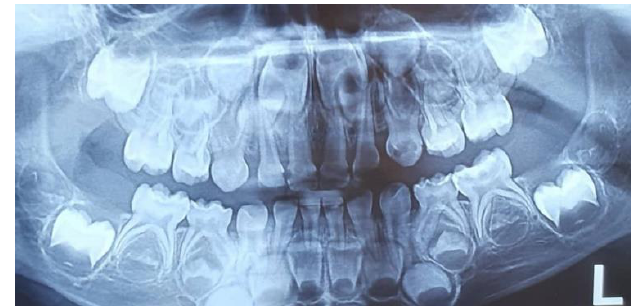
Fig. 1. Bilateral three rooted maxillary and unilateral bi-rooted mandibular primary